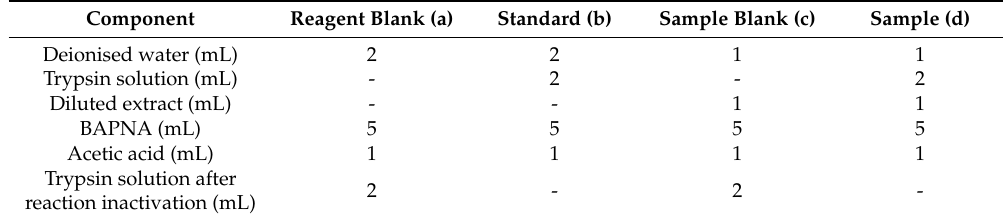
Table 1. The trypsin inhibitor activity assay